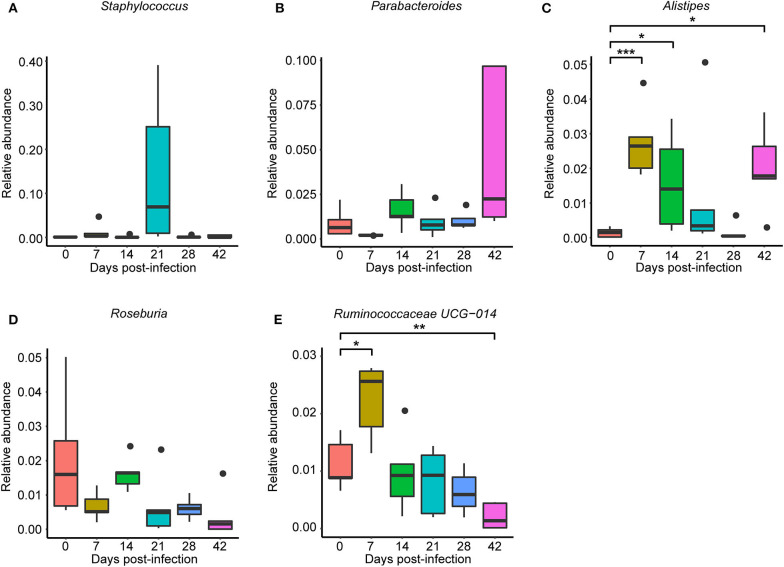
Relative abundances of significantly altered top 15 most important gut genera associated with Schistosoma japonicum infection. Each column represents one group. (A)
Staphylococcus. (B)
Parabacteroides. (C)
Alistipes. (D)
Roseburia. (E)
Ruminococcaceae UCG-014. The top and the bottom whiskers indicate the maximum and the minimum values, respectively, and the hyphen represents the median value (*p < 0.05, **p < 0.01, ***p < 0.001).